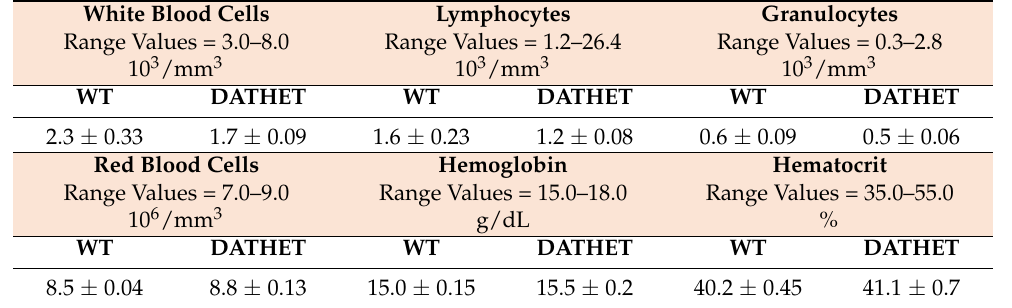
Table 1. Main hematological parameters of WT- and DATHET-treated groups. For each blood parameter, range values, and final values are displayed. This table clearly shows the negligible variations (comprised between − 10% and +10% when compared to water controls), preserving in a physiological range the values in both groups treated with MVs. The data are confirming the non-toxic effect of Moringa . White Blood Cells Lymphocytes Granulocytes Range Values = 3.0–8.0 Range Values = 1.2–26.4 Range Values = 0.3–2.8 10 3 /mm 3 10 3 /mm 3 10 3 /mm 3